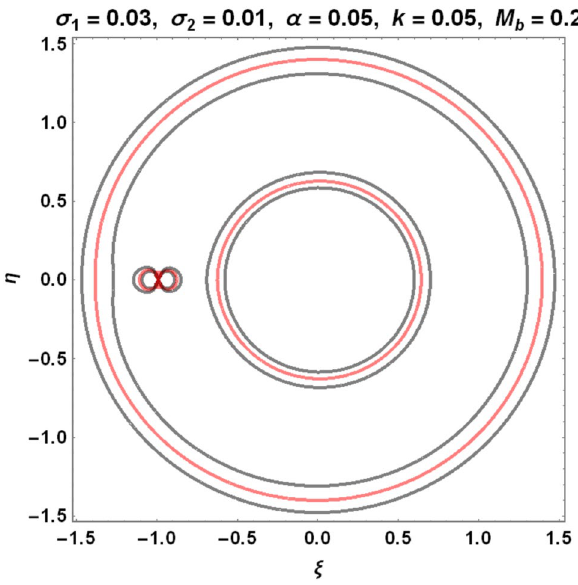
= 0.01215, e = 0.0549, a = 1.000453, A = 0.0000003686, T = 0.01, Figure 3. Zero velocity curves for µ σ 1 = 0.03, σ 2 = 0.01, α = 0.05, k = 0.05, M b = 0.2 showing the boundary